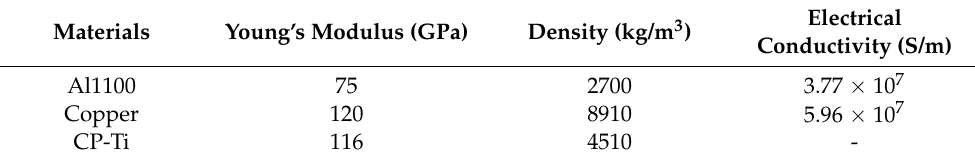
Table 6. Selected material properties used in the simulations.